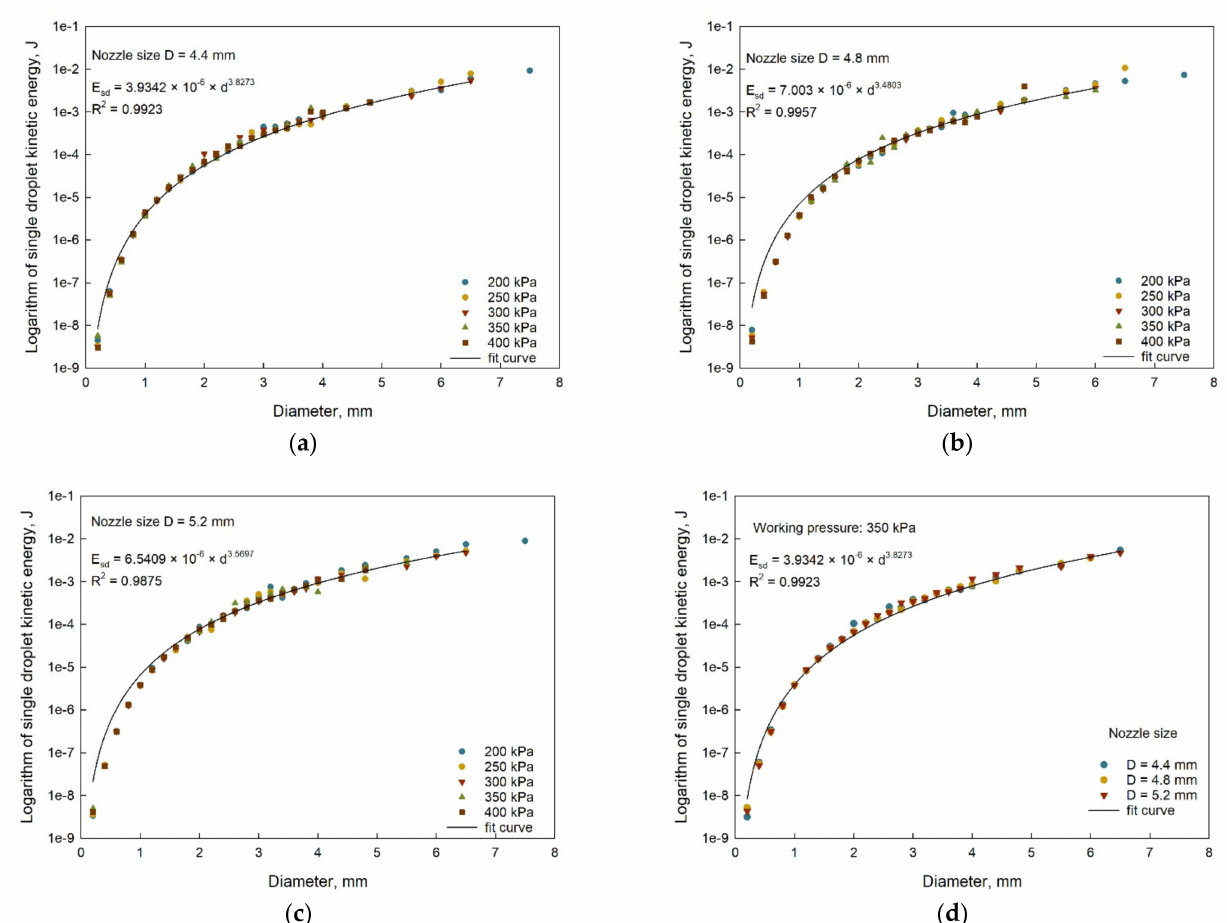
Figure 10. Relationships between the mean droplet kinetic energy and the droplet diameter with nozzle sizes of ( a ) D = 4.4 mm, ( b ) D = 4.8 mm, ( c ) D = 5.2 mm under different pressures and ( d ) under the working pressure of 350